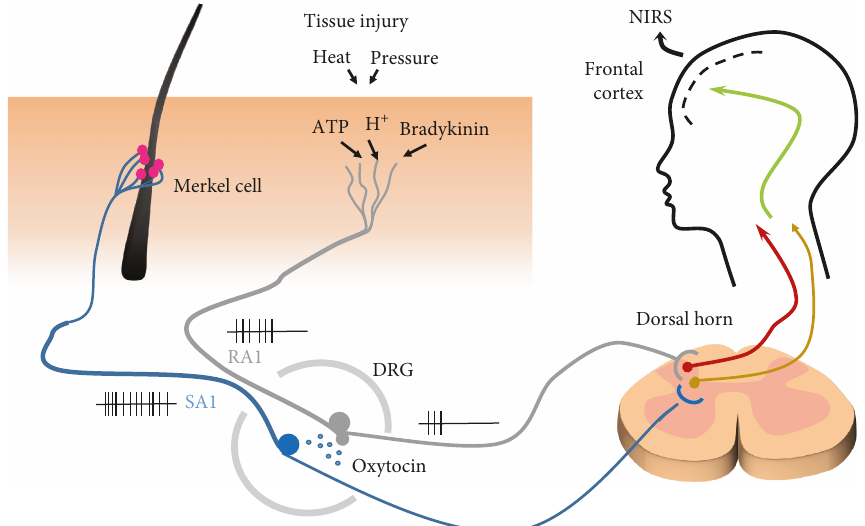
Figure 3: Proposal mechanism for physical analgesia by soft touch involving oxytocin in the DRG. As shown in Figure 2, the pain sensation can be recorded at the frontal cortex by near-infrared spectroscopy